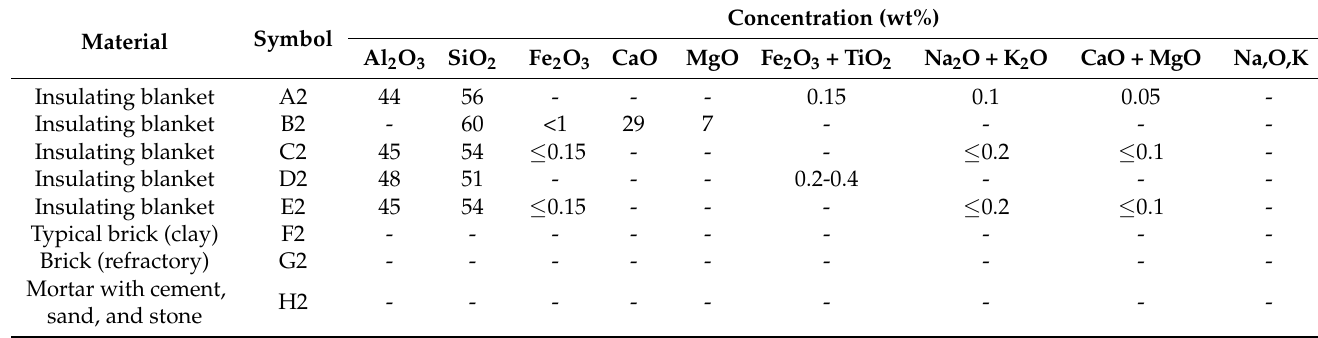
Table 2. Composition of the selected insulating blankets and ceramic materials.